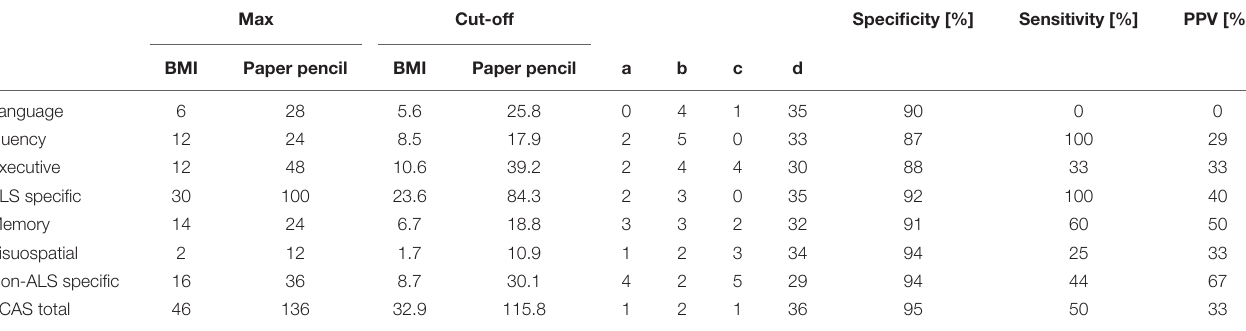
TABLE 3 | Predictive validity of the ECAS BMI version.